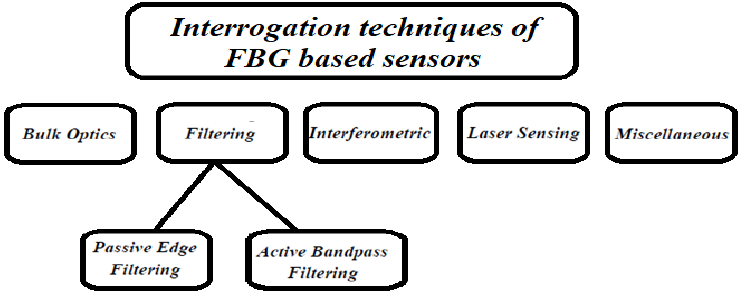
Figure 13. Classification of the interrogation techniques of FBG sensors: bulk optics, filtering, interferometric, laser sensing, and miscellaneous.